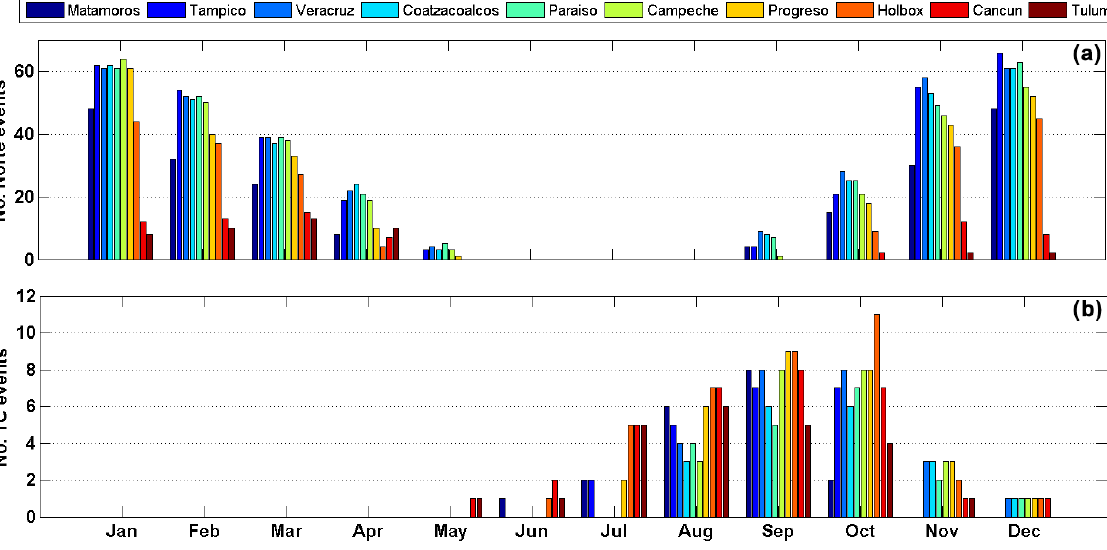
Figure 4. Sum of the number of events per month for the entire study period related to (a) Nortes and (b)